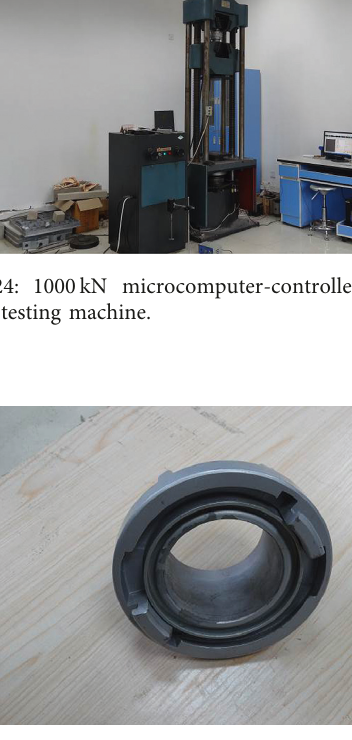
Figure 25: Front view of the